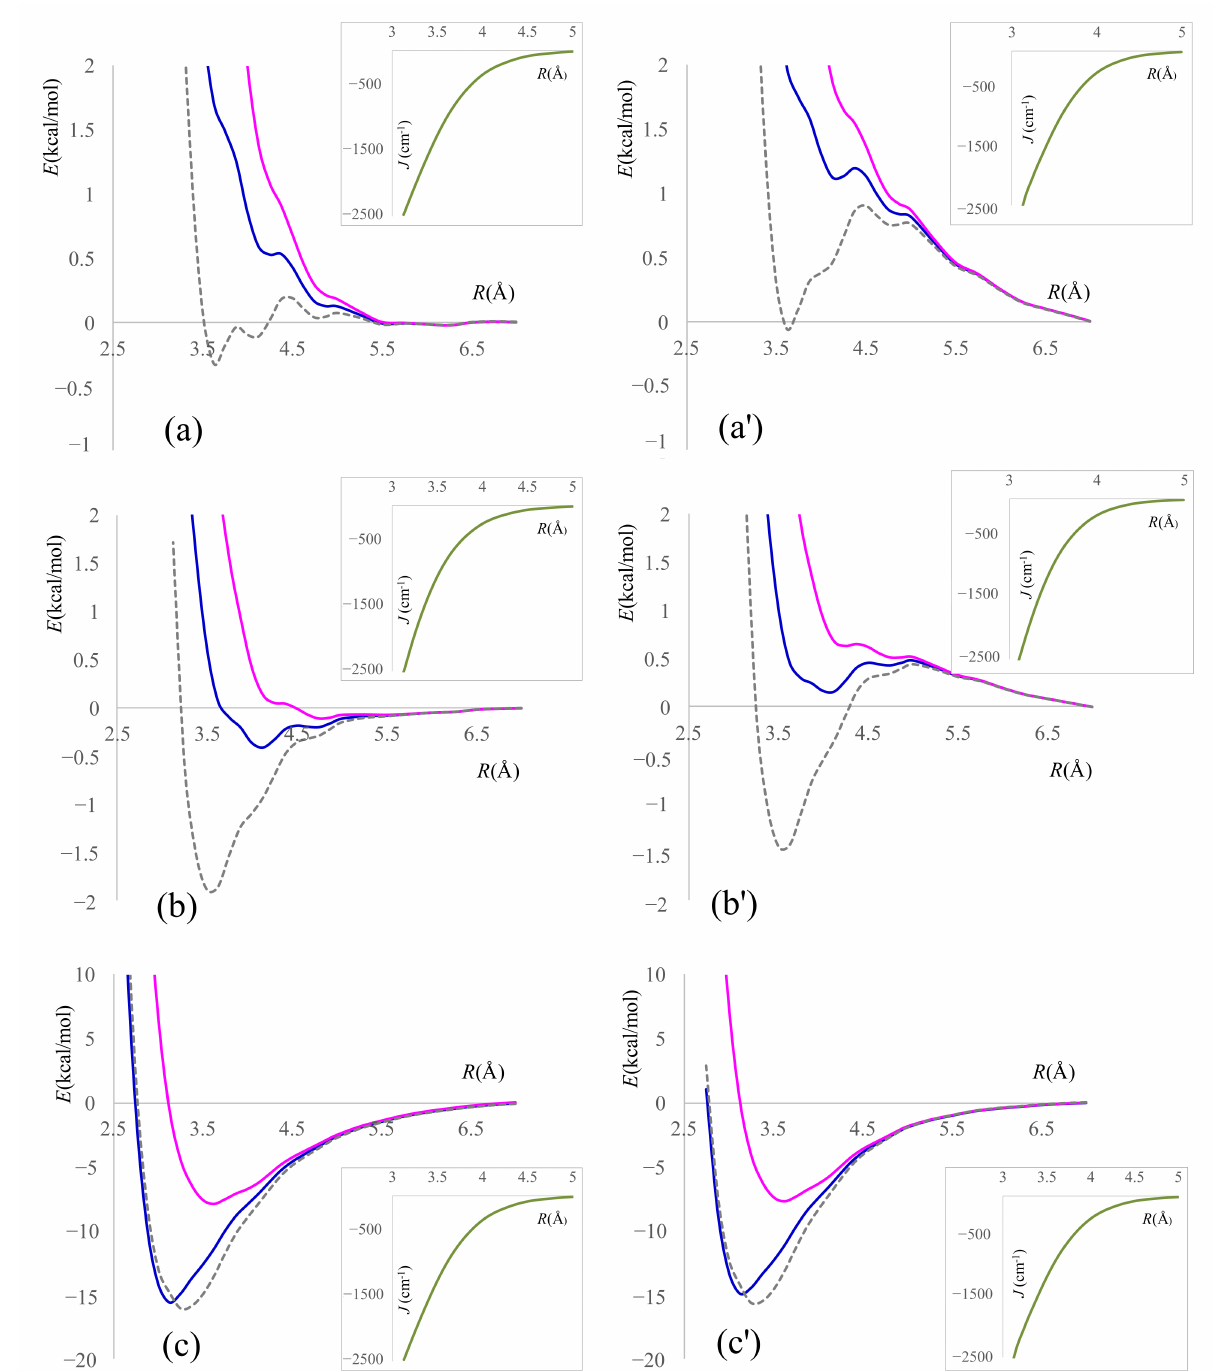
Figure 5. The unrestricted DFT energy curves for phenalenyl dimer in staggered conformation ( D 3 d symmetry), as a function of interplanar separation, R . Methods: ( a ) and ( a (cid:48) ) by B3LYP, ( b ) and ( b (cid:48) ) by CAM-B3LYP and ( c ) and ( c (cid:48) ) by Grimme’s D3 correction to B3LYP;left side: 6-31+G* basis set; right side: def2TZVP basis set. The magenta (upper) curves correspond to triplet states (high spin—HS); the blue lines correspond to broken symmetry (BS) configuration. The dashed grey lines are singlet profiles (low spin—LS) emulated from triplet curve and the BS estimation of exchange coupling via Equations (1) and